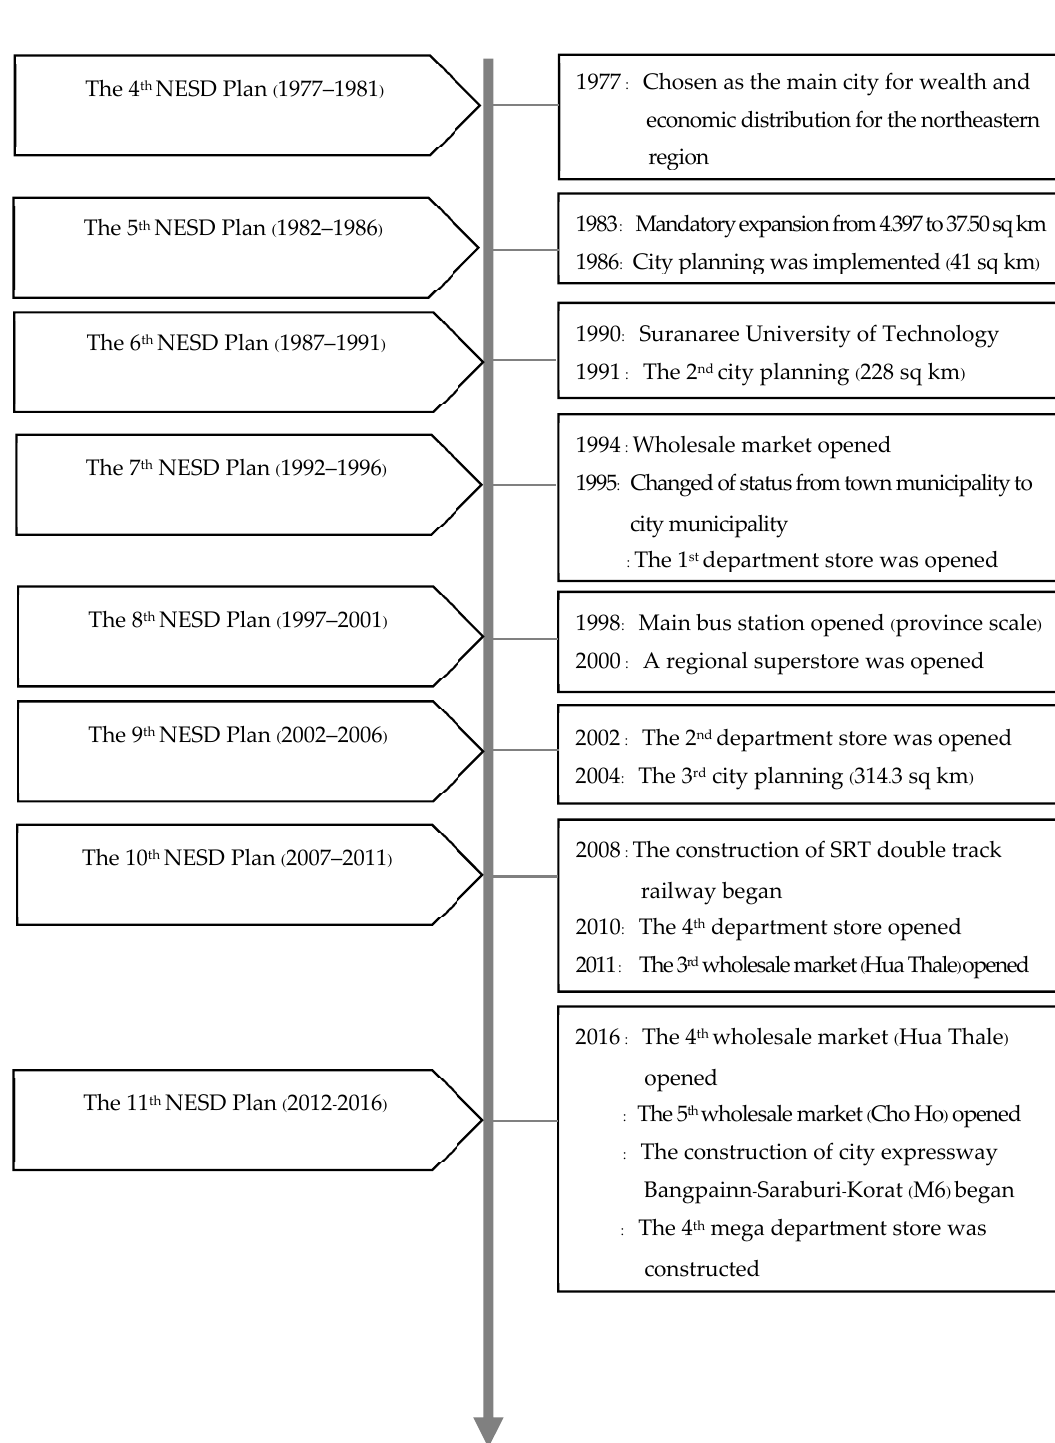
Figure 2. Timeline during and after implementing the National Economic and Social Development Plan ( NESD Plan ) throughout the years.